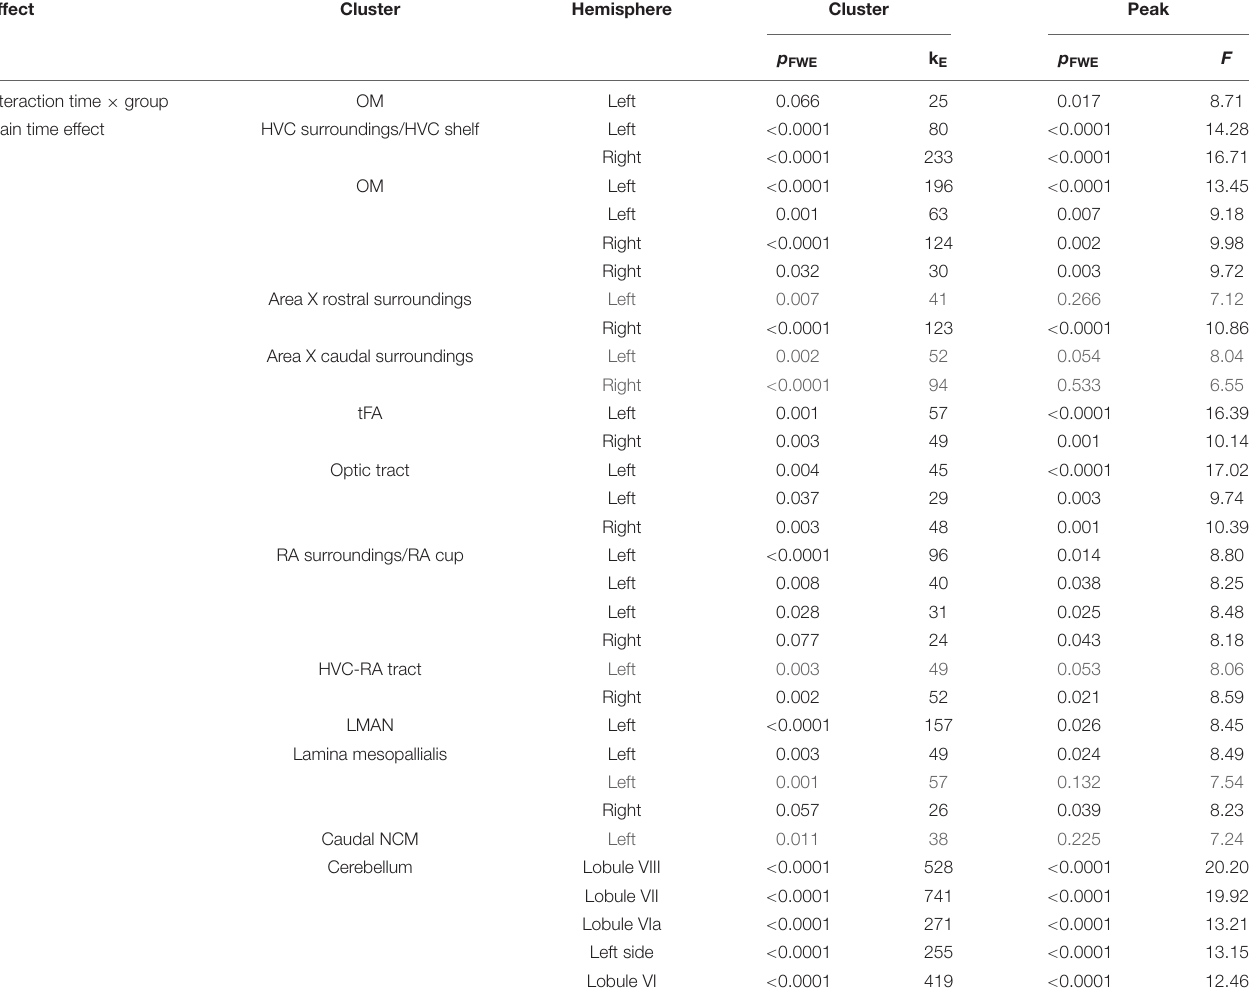
TABLE 2 | Overview interaction and time effect in FA in small volume